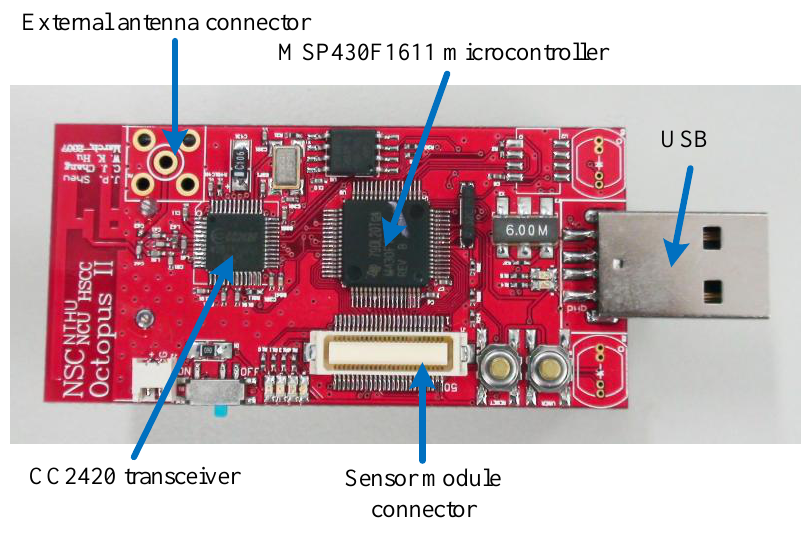
Figure 9. Octopus II-A sensor node utilized in this study.